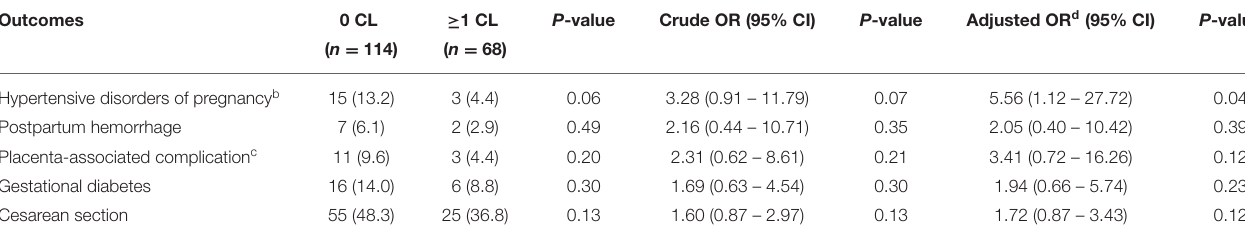
TABLE 2 | Maternal outcomes of singleton birth after frozen-thawed embryo transfer in the absence (0 CL) or presence ( ≥ 1 CL) of a corpus luteum a . Outcomes 0 CL ≥ 1 CL P -value